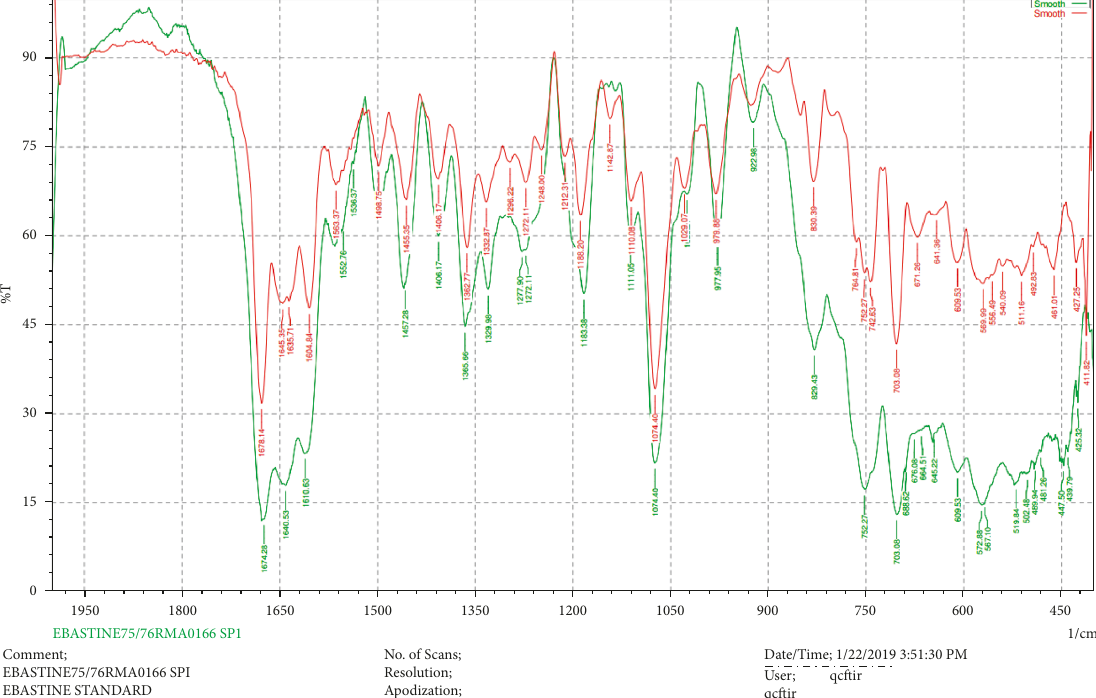
Figure 7: Chromatogram of FTIR for ebastine (green color: FTIR chromatogram of standard drug ebastine, red color: FTIR chromatogram of the ebastine mixed with all the excipients).